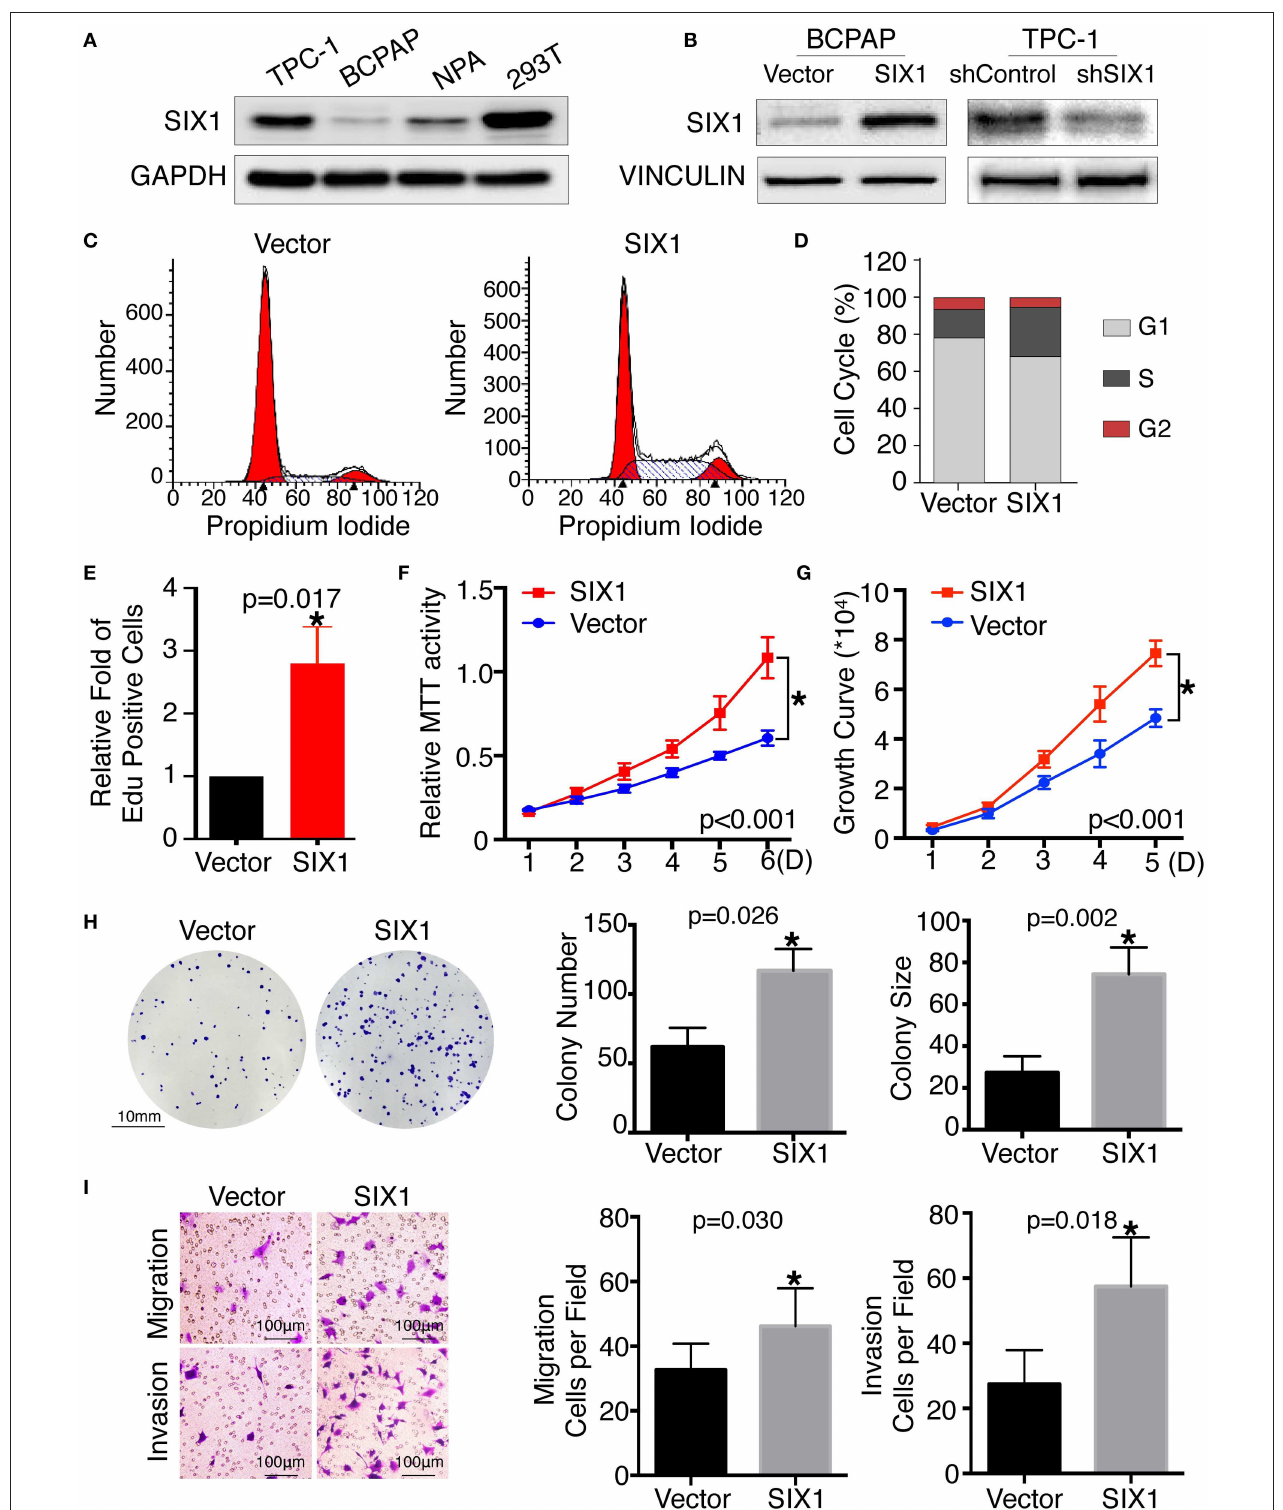
FIGURE 2 | Ectopic expression of SIX1 increased the proportion of cells in S phase and promoted proliferation, migration and invasion in BCPAP cell lines. Protein abundance of SIX1 in PTC cell lines by western blot analysis (A) . Western blot analysis confirmed the efficiency of ectopic expressing SIX1 in BCPAP cells or silencing SIX1 in TPC-1 cells (B) . Representative images of cell cycle plot (C) and quantitative results ( n = 3) (D) . Quantitative results of EdU staining of cells with SIX1